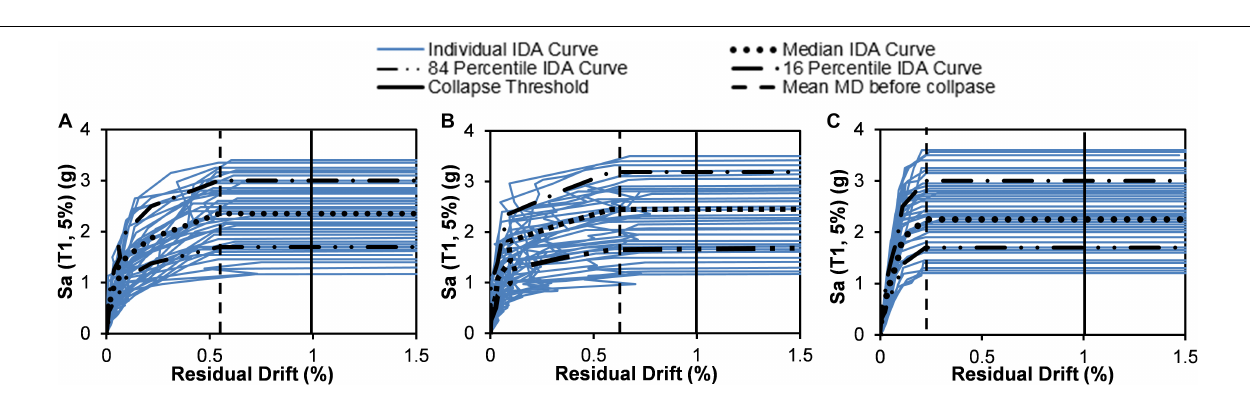
FIGURE 13 | IDA curves for residual drift for (A) SMA-B, (B) SMA-B-T, and (C) Steel-RC bent under long duration